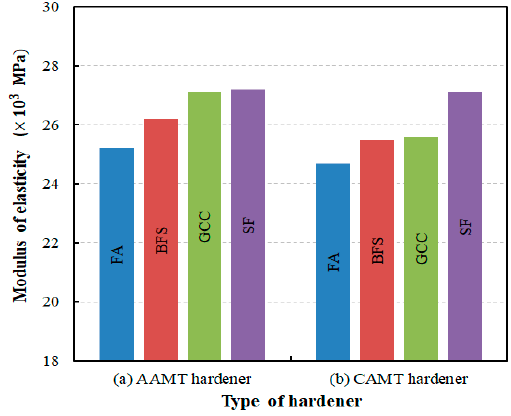
Figure 7. Elastic moduli by hardener and filler type.